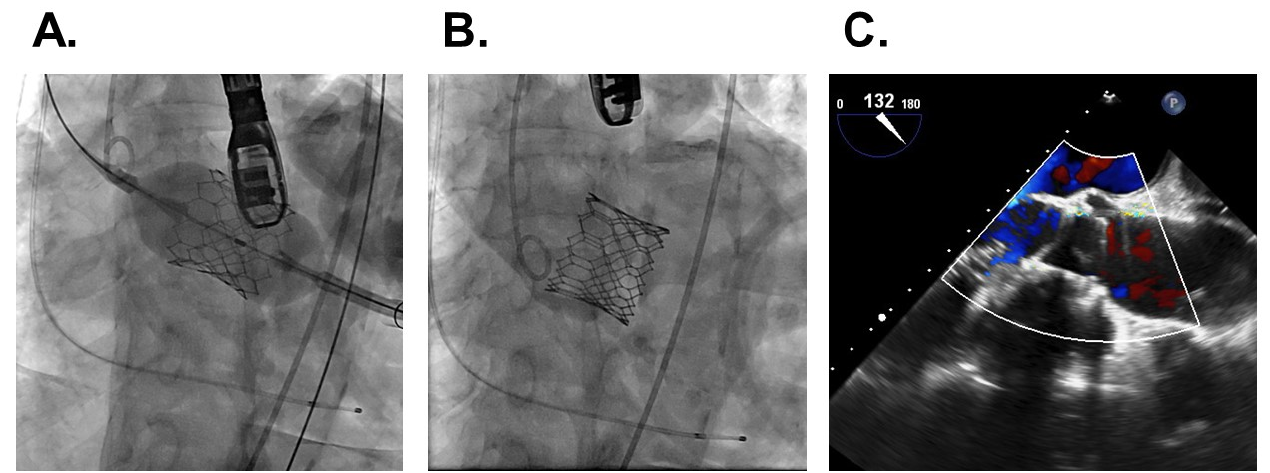
Figure 6. Trans ‐ apical transcatheter aortic valve replacement. Aortic valve implantation ( A ), aortography without any peri ‐ valvular leak ( B ), and transesophageal echocardiography displaying no peri ‐ valvular leak ( C ).